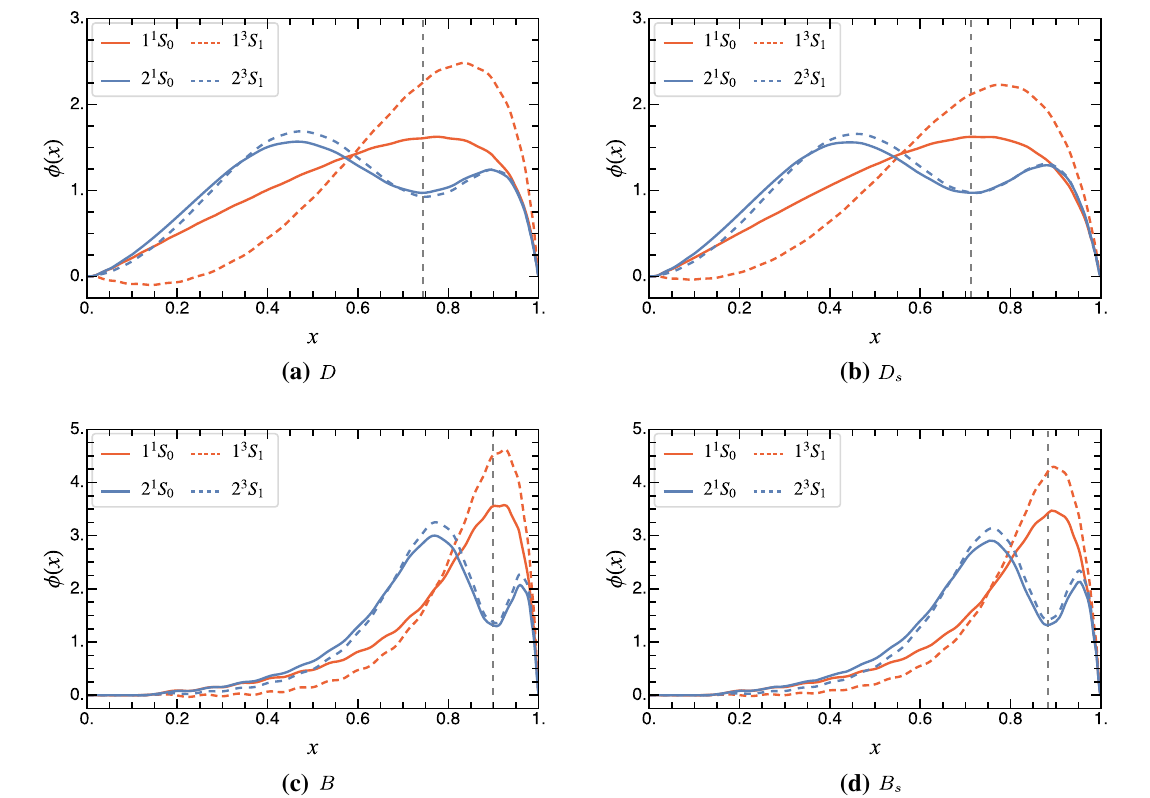
Fig. 5 DAs of pseudoscalar (solid curves) and vector (dashed curves) states of the heavy-light systems at N max = L max = 32. The vertical dashed gray lines is at x = m q /( m q + m ¯ q )